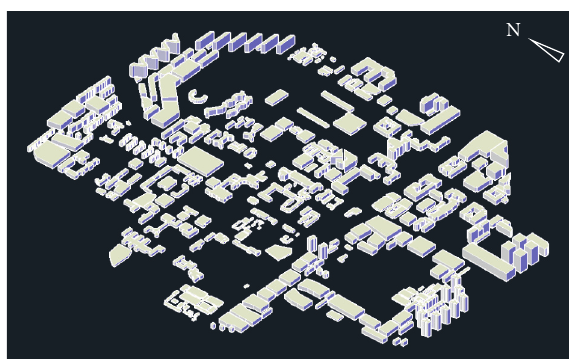
Figure 9: The simplified 3D model of the building